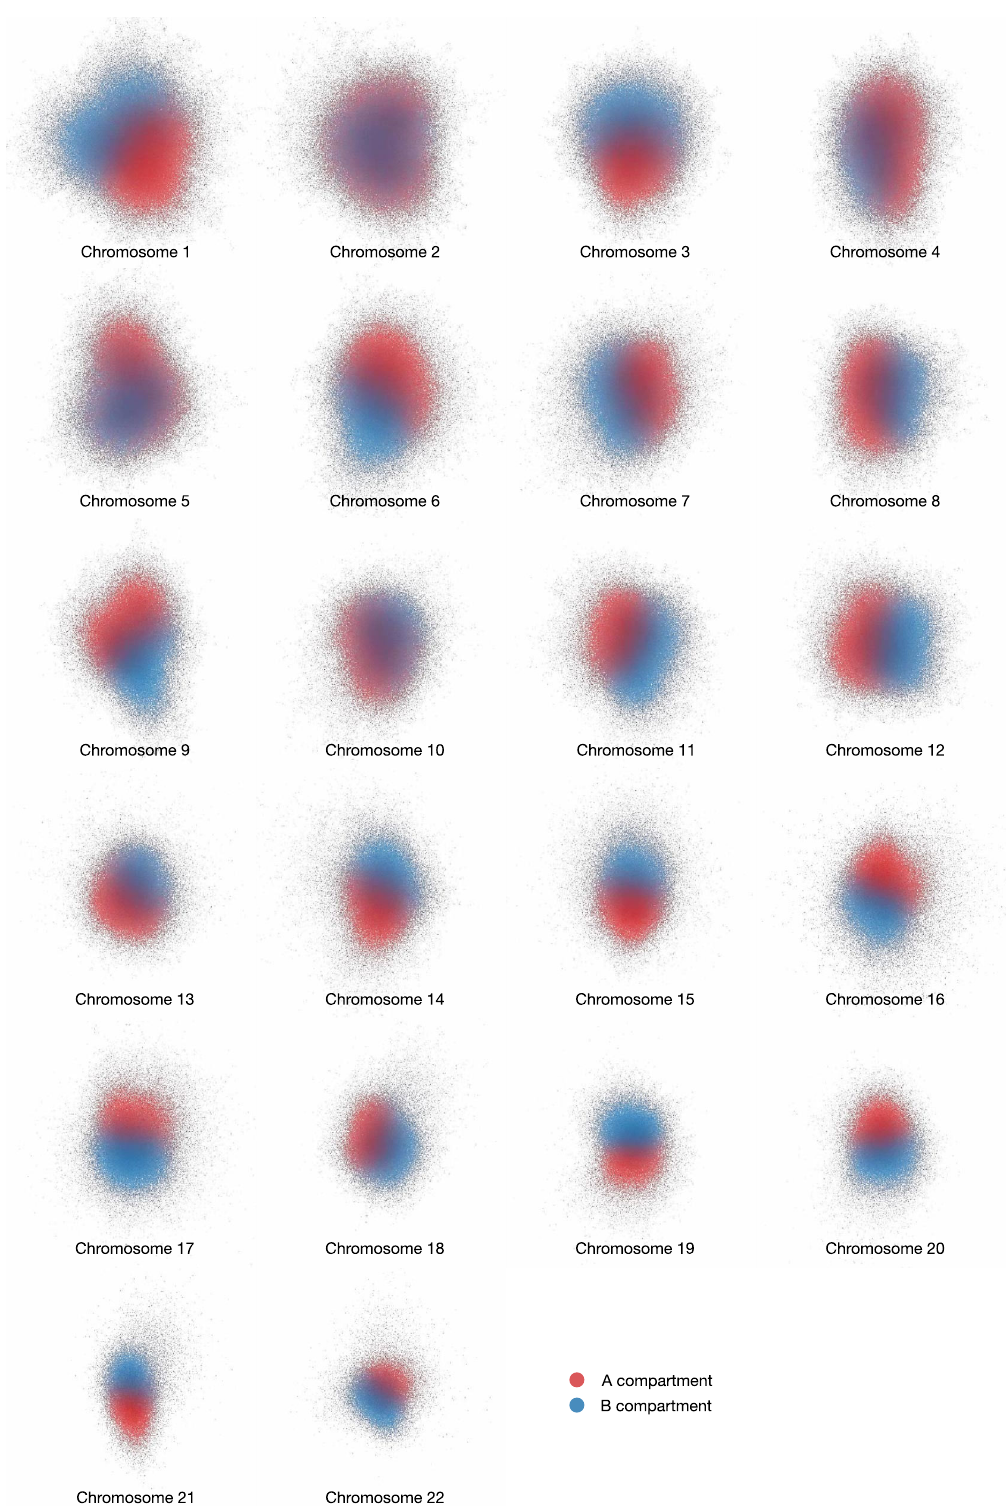
FIG. 14. Superposition of an ensemble of 3D structures for all 23 chromosomes. A total number of 1000 conformations are aligned and superimposed for each chromosome. Each point represents a single locus from one conformation, with colors representing the A and B compartments. Note that the A and B compartments do not necessarily correspond to the same epigenetic state across different chromosomes since the assignment of label A or label B is